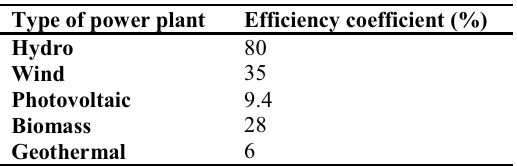
Table 2: The average energy efficiency coefficients for power plants types